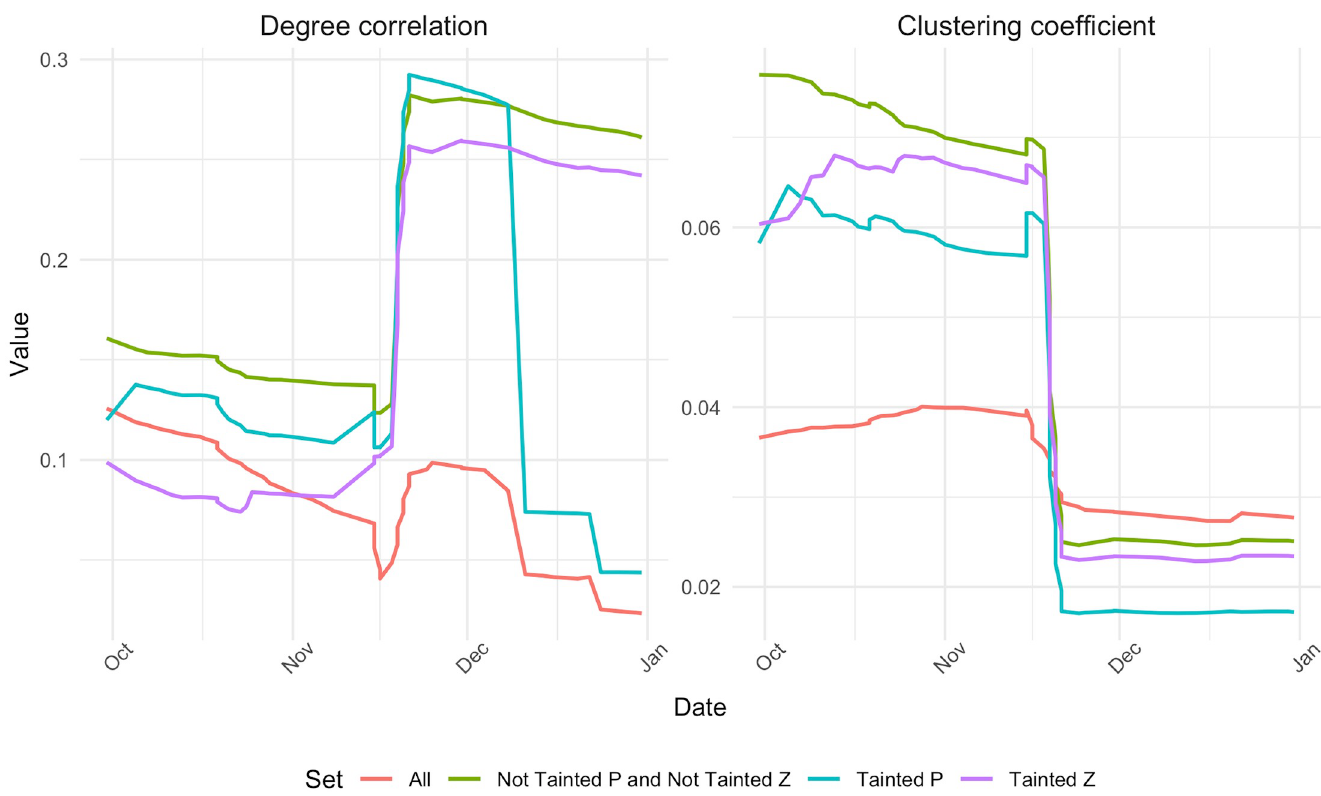
Fig 6. Evolution of degree correlation and clustering coefficient in the full transaction network and three sub-networks in October, November and December 2010.